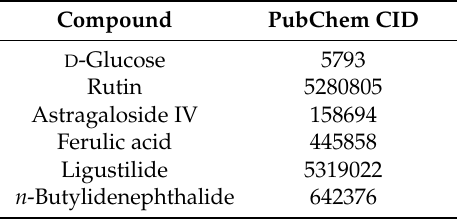
Table 1. Chemical Compounds Studied in this